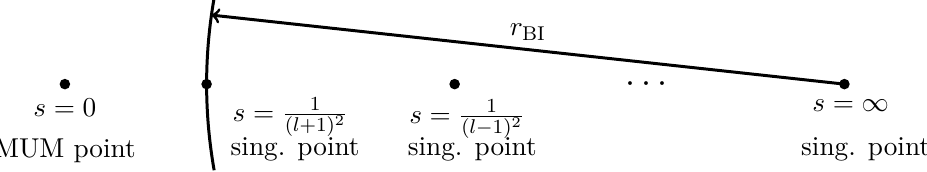
Figure 3 . Singularities of the Fuchsian operator L l . The radius of convergence of the Bessel integral representation (2.10) of F σ is denoted by r BI l